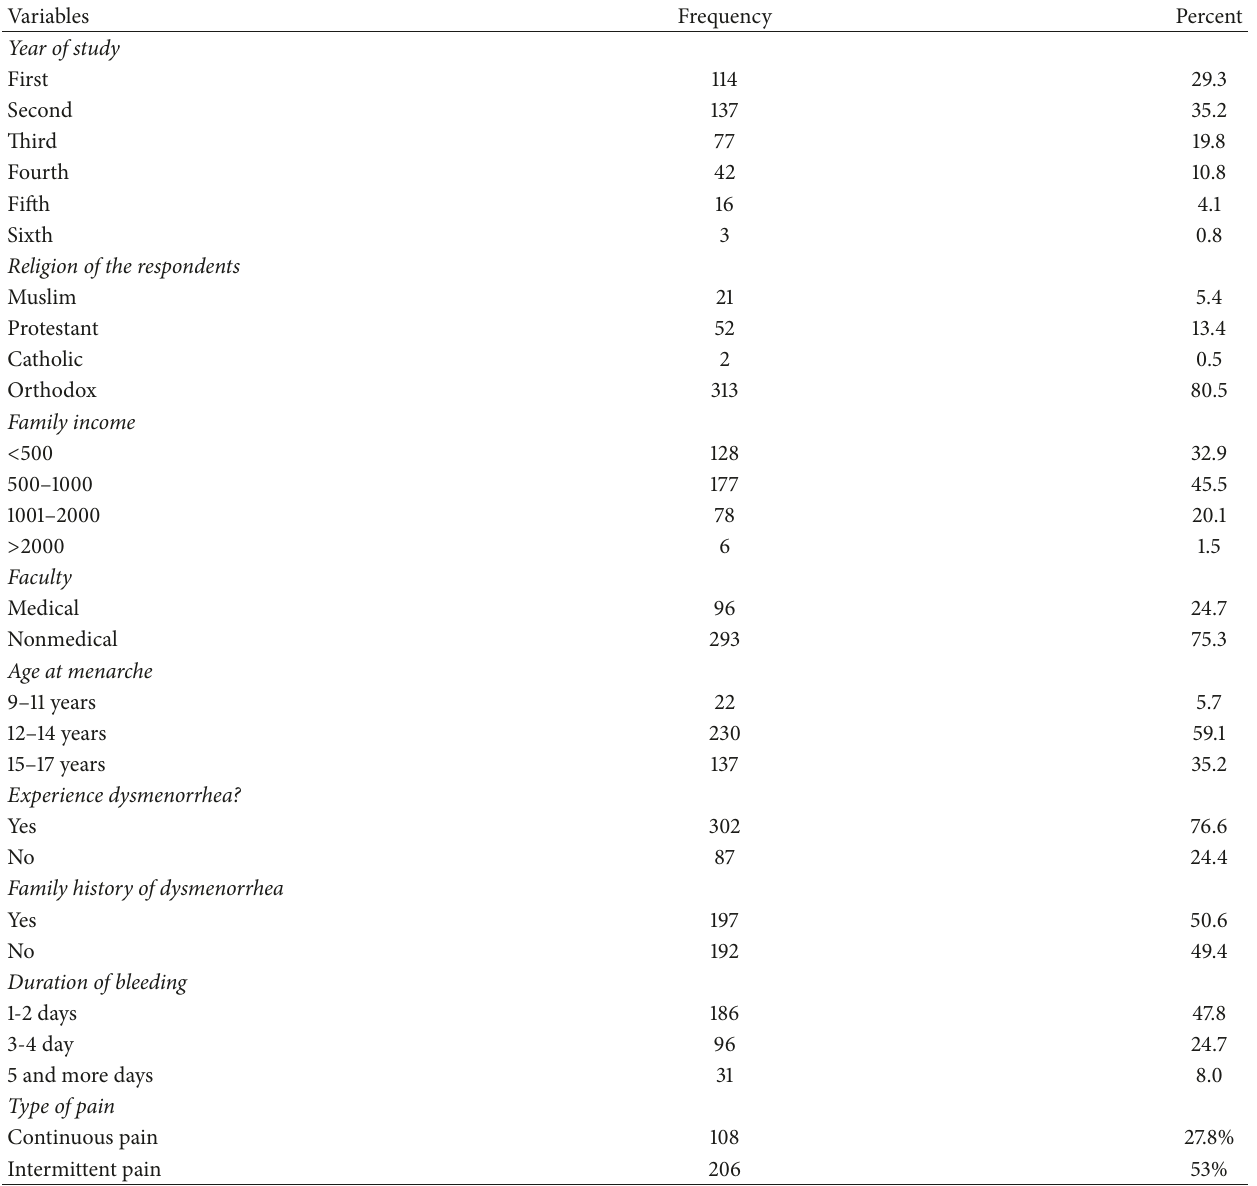
Table 1: Sociodemographic and menstrual characteristics of respondents, Gondar,